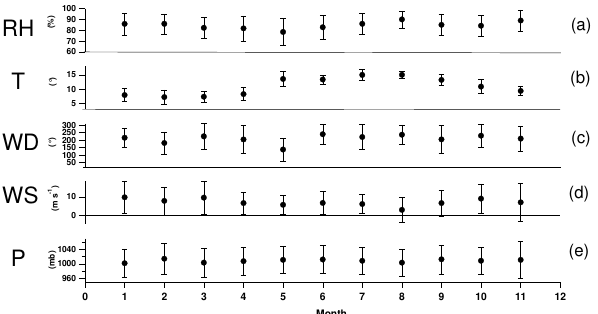
Fig. 1. Overview of meteorological parameter for each month of Figure 1. Overview of meteorological parameter for each month of year 2008: (a) RH year 2008: (a) RH (%), (b) Temperature ( ◦ C), (c) WD ( ◦ ), (d) WS (%), (b) Temperature (ºC), (c) WD (º), (d) WS (m s -1 ) and (e) atmospheric pressure (mb). Wind directions are vector averages and all error bars are 1 σ (±one sigma standard (ms − 1 ) and (e) atmospheric pressure (mb). Wind directions are deviation). vector averages and all error bars are 1 σ ( ± one sigma standard